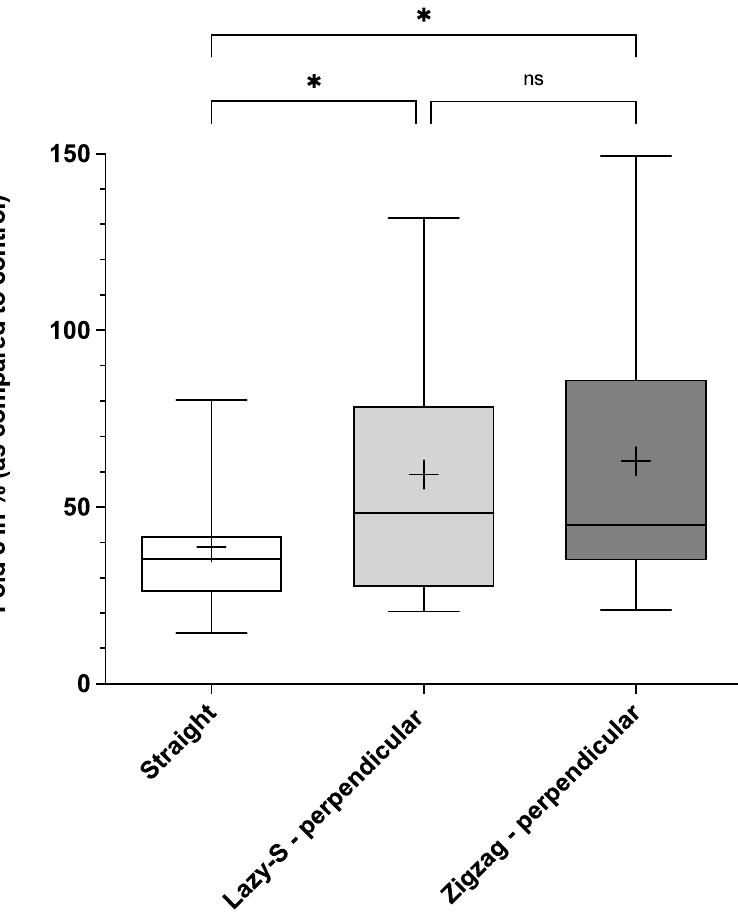
Figure 2. Comparison of resistance to deformity (c) between three main incision patterns. Conven- tional straight, Lazy-S and Zigzag incisions (both with perpendicular (90 ◦ ) placement of sutures) were tested for their biomechanical stability. The mean is indicated by a cross. The bottom and top of the box are the 25th and 75th percentile. Error bars (whiskers) indicate the 10th and 90th percentile. * p < 0.05; ns, not significant. For each group 17 incision-patterns were tested. For both Lazy-S and Zigzag incision patterns resistance to deformity was reduced when sutures were placed in tensile direction. As compared to orientation of sutures in a perpendicular manner, the mean resistance to deformity was 36.7 (20.5)% vs. 59.2 (43.0)% for Lazy-S and 44.9 (25.6)% vs. 63.0 (42.7)% for Zigzag incisions. The difference was statistically significant for Lazy-S incision patterns ( p < 0.05). Consequently, no statistically significant difference in resistance to deformity was observed for both Lazy-S and Zigzag incision patterns with suture placement in tensile direction when compared to straight incision patterns (data not shown; also refer to Supplementary Data). pendicular suture placement demonstrated highest biomechanical stability (Figures